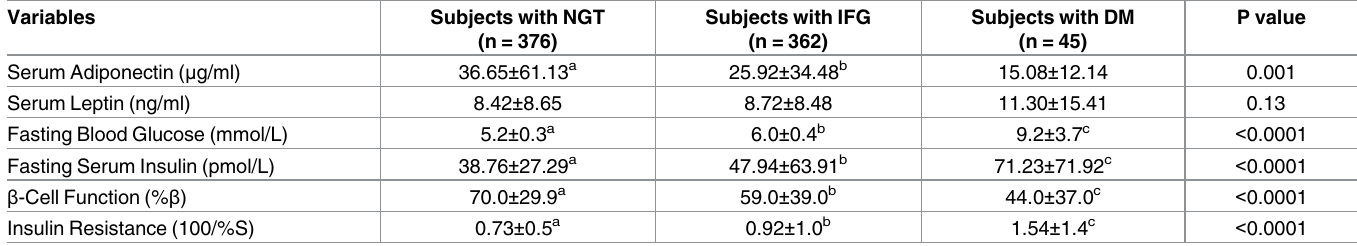
NGT, normal glucose tolerance; IFG, impaired fasting glucose; and DM, diabetes mellitus Values shown are mean ± standard deviation a, b and c indicates p < 0.05 for group comparisons: a for NGT vs. DM, b for NGT vs. IFG and c for IFG vs.